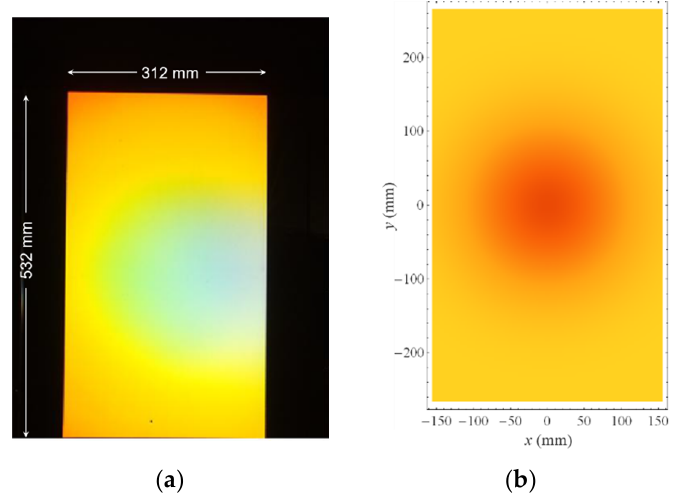
Figure 20. ( a ) diffraction efficiency for the P-HOE. ( b ) model predictions. A 19 mm thick float glass plate was used for the recording element and the power density was reduced by a factor of 1.5.